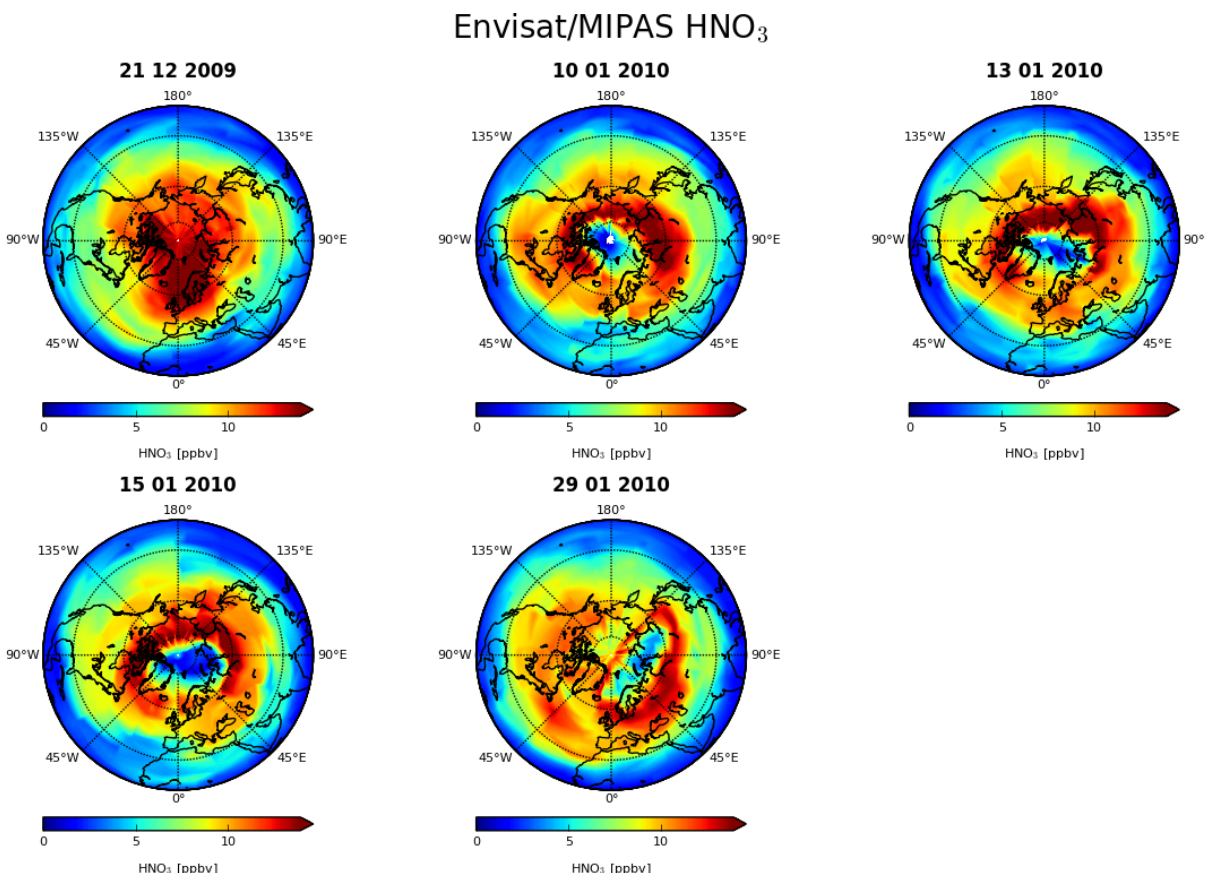
Figure 2. Distribution of HNO 3 as observed by Envisat/MIPAS on 21 December 2009, 10, 13, 15, and 29 January 2010 at at 21km ( ∼